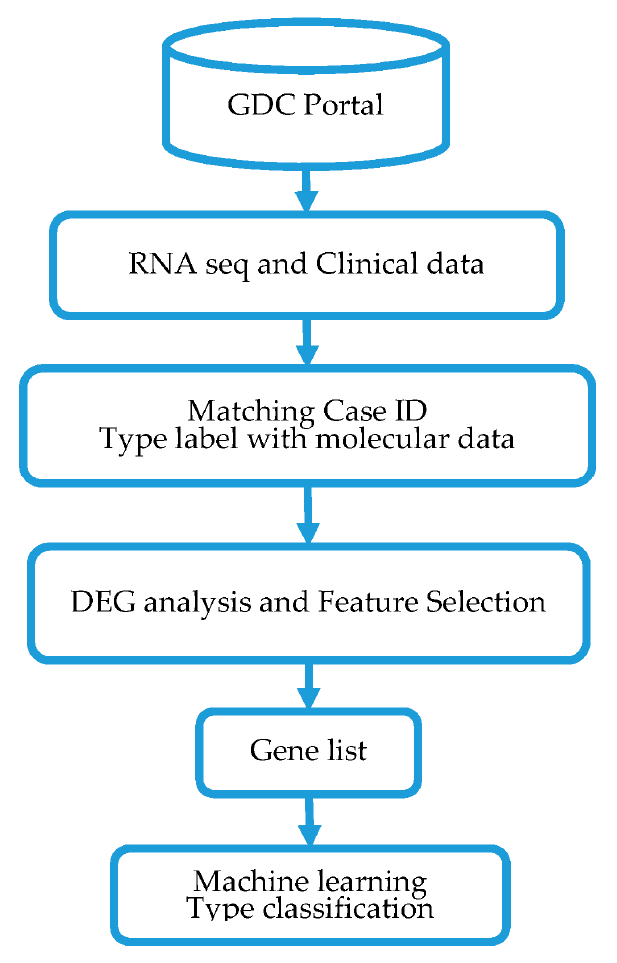
Figure 1. Project design, data processing and analysis workflow for classification of triple negative breast cancers (TNBC) and non-TNBC using machine learning method. GDC denotes the genomics data commons; DEG denotes differentially expressed genes.